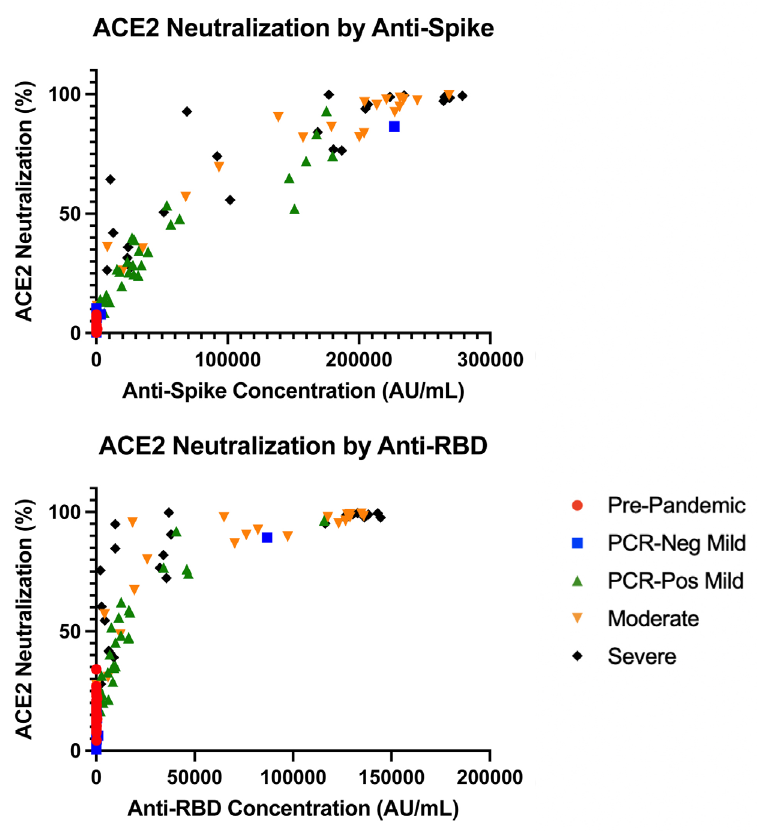
Figure 2. Analysis of ACE2 inhibition by anti-S1(A) and anti-RBD (B) IgG antibodies by disease severity. Quantitative plasma anti-S had a correlation of r = 0.885 ( P < 0.001) and anti-RBD had a correlation of r = 0.75 ( P <0.001) to ACE2